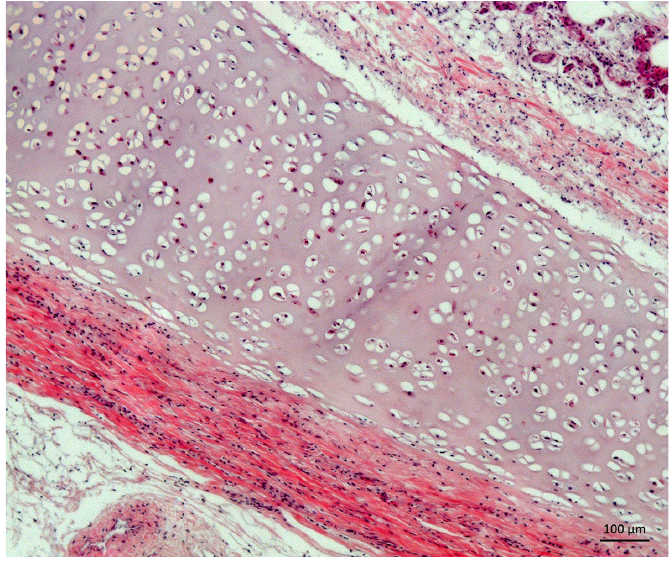
Figura 5. Cartilagem do anel traqueal com disposição irregular dos condrócitos (displasia) e aumento do espaço entre a cartilagem e o tecido conjuntivo fibroso da submucosa, HE,